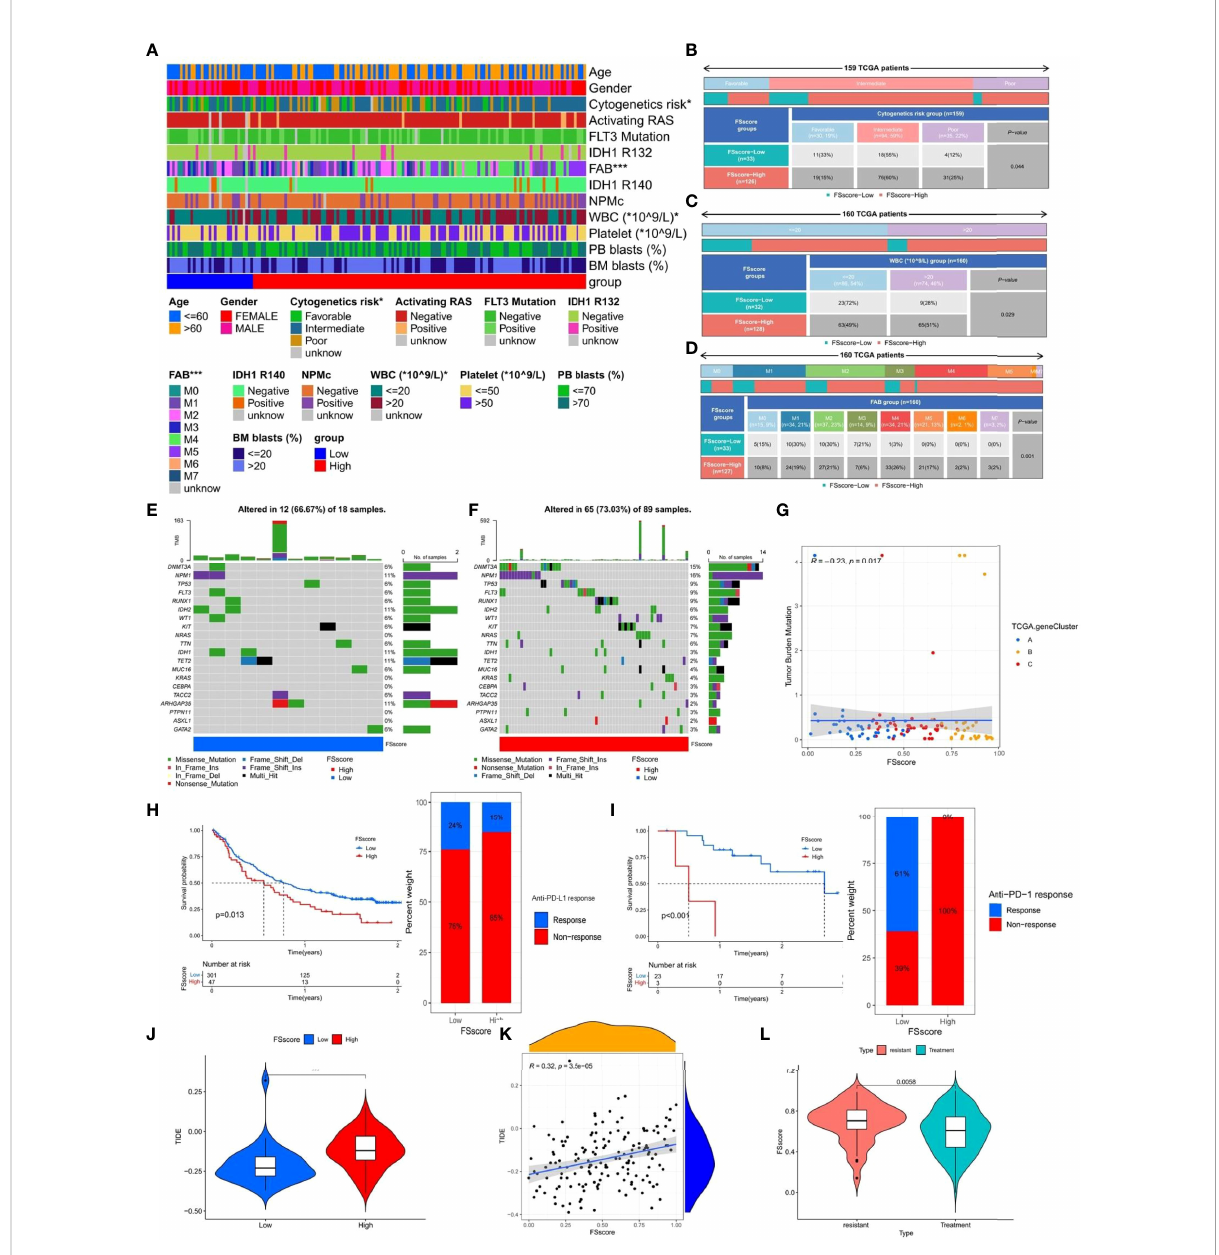
FIGURE 7 The relationship between clinicopathological factors, tumor somatic mutations, immunotherapy and FSscore. (A – D) Correlation analysis between clinicopathological factors and FSscore in the TCGA group, Fisher ’ s exact test, *P < 0.05. (E, F) The characteristics of tumor somatic mutations in the high and low FS score groups of the TCGA group, WBC: white blood cell, PB: peripheral blood, BM: Bone marrow, IDH: isocitrate dehydrogenase, NPMc: nucleophosmin. (G) Correlation analysis between TMB and FSscore in the TCGA group. (H, I) Differences in survival of patients and the proportion of patients in high and low FSscore groups of immune checkpoint inhibitor treatment cohorts (H: IMvigor210, I: GSE78220), log rank test. (J) Differences in TIDE scores of the high and low FS score groups in the TCGA group. (K) Correlation analysis between TIDE score and FSscore in the TCGA group. (L) The difference in FSscore between drug-resistant and nonresistant patients. ***P <